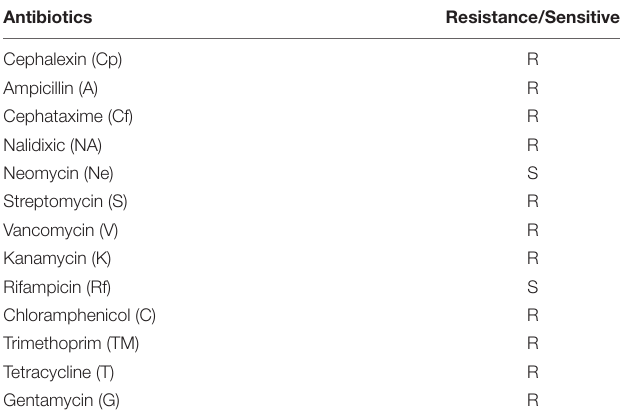
FIGURE 2 | Antioxidant activity (A) superoxide dismutase (SOD), (B) catalase (CAT), (C) glutathione (GSH) of PR19 at various pH (5–9) and high salt (20%) concentrations.